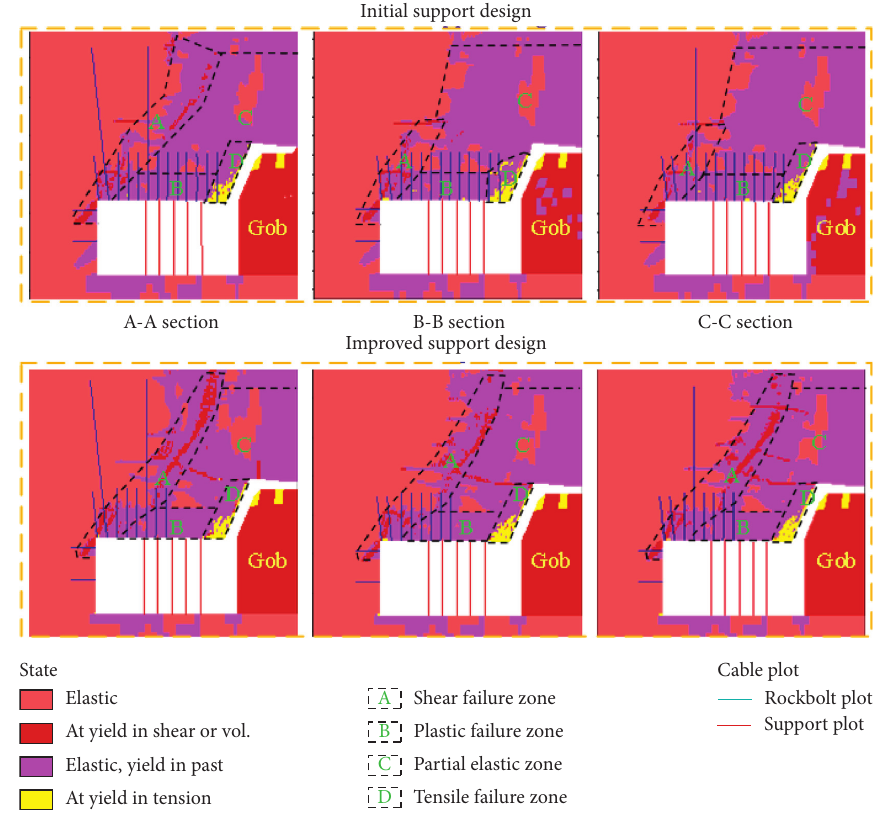
Figure 19: Plastic zone distribution of the two support designs.